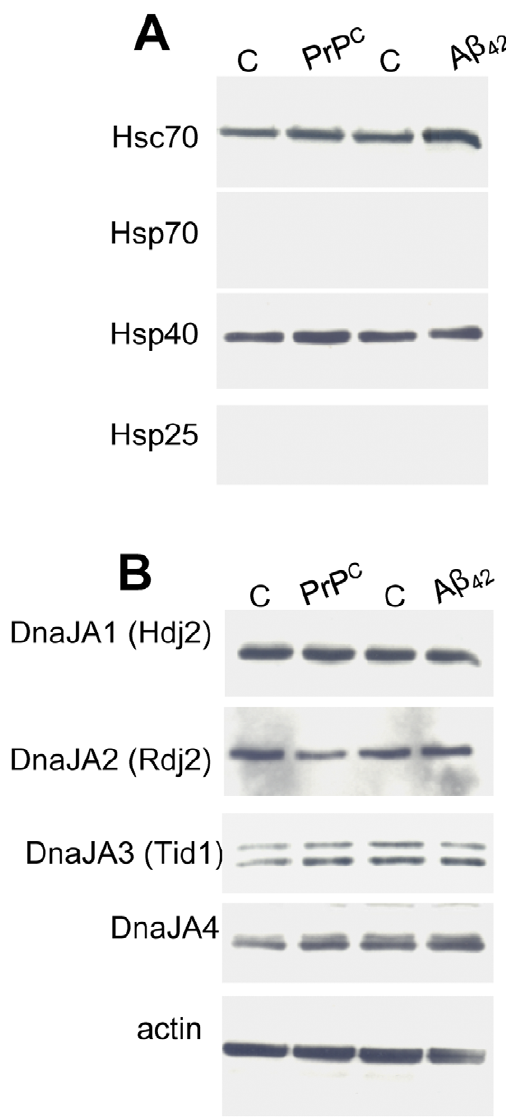
Figure 6. A b 42 or bovine rPrP C do not alter expression of the J proteins DnaJA1(Hdj2), DnaJA2(Rdj2), DnaJA3 (Tid1) or DnaJA4 in neural cells. CAD cells were incubated with 3 m M A b 42 or 0.5 m M bovine rPrP C for 48 hours and washed in PBS prior to lysis. (A) Western analysis of heat shock proteins (B) The J proteins; DnaJA1(Hdj2), DnaJA2(Rdj2), DnaJA3 (Tid1) or DnaJA4 were detected by Western blot analysis. b -actin is shown as a loading control. Data are representative of 4 separate experiments.